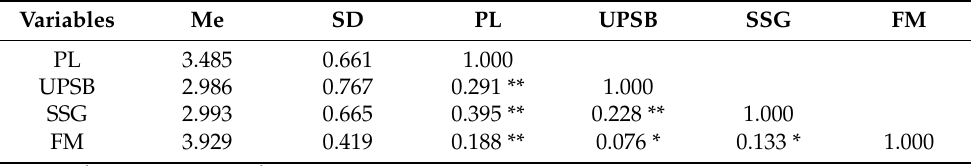
Table 3. Mean value, standard deviation, correlation coefficient of